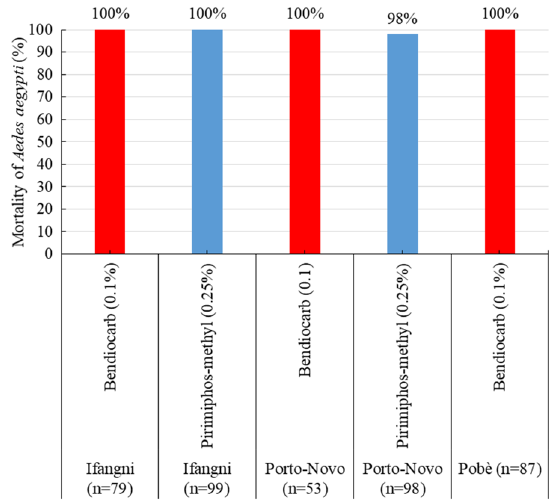
Fig. 2 Mortalities observed 24 h after exposure of Ae. aegypti to bendiocarb and pirimiphos methyl